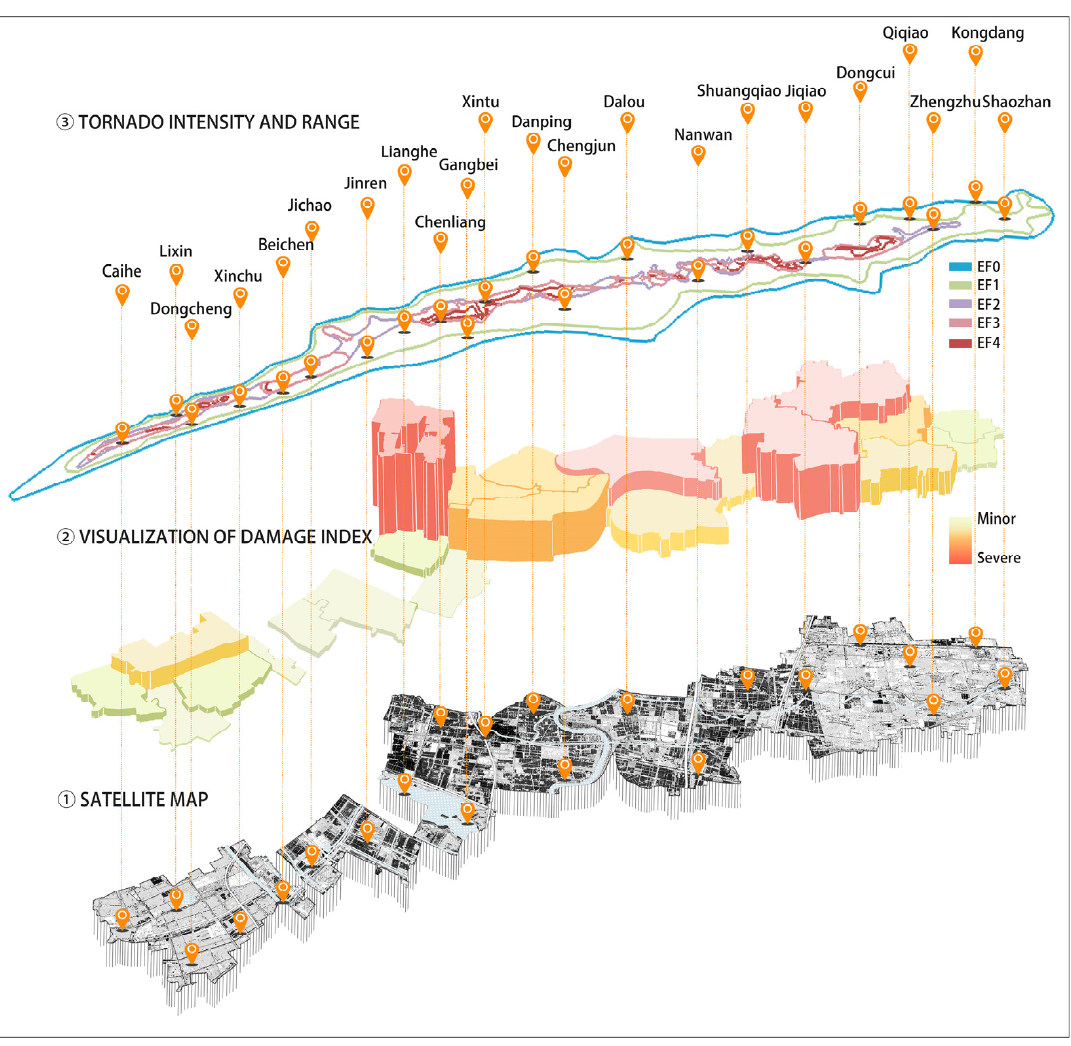
Figure 3. The damage index, tornado intensity, and range. The results of the regression analysis of the 2557 data points on housing damage (Table 3) showed that 1025 houses suffered SD (40.1%) and 1007 were UR (39.4%). It was found that 1980 of the damaged houses had one story (77.4%), 67.6% were masonry- concrete structures, and 21.7% were masonry structures. Different tornado intensities caused different damage levels to houses. The EF3 tornado damaged the most houses (1211, 47.4%), followed by the EF1 (30.9%), EF4 (17.9%), and EF2